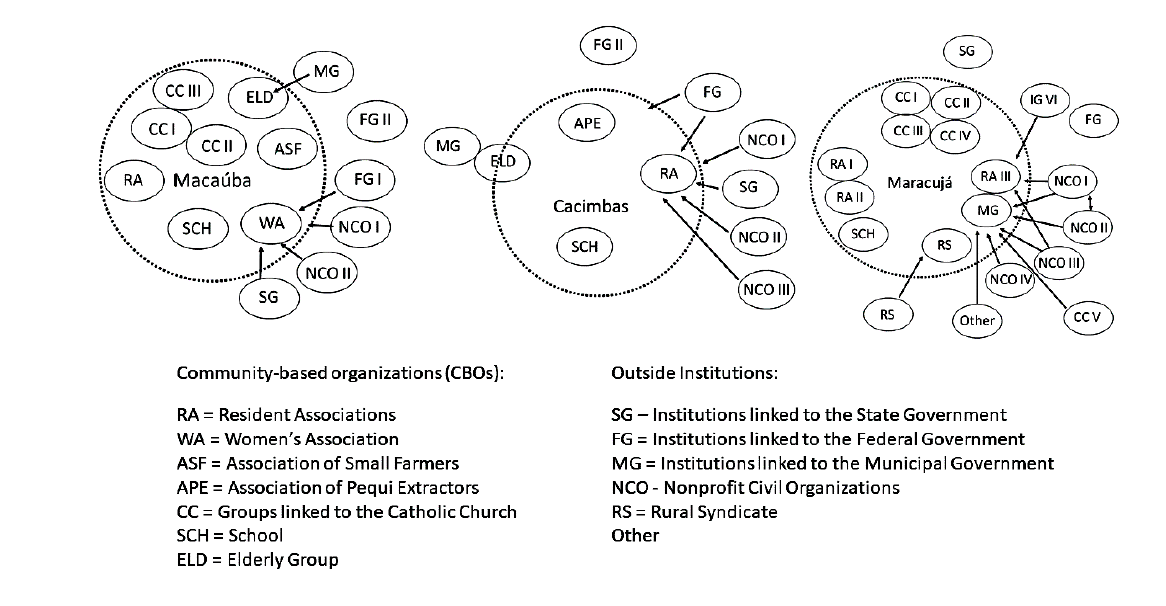
Fig. 6 . Social networks of the rural communities in Araripe, northeastern Brazil. Organizations within the dotted circle are community-based organizations (CBOs) and those outside the circle are partners in levels above the community. The arrows indicate partnership between